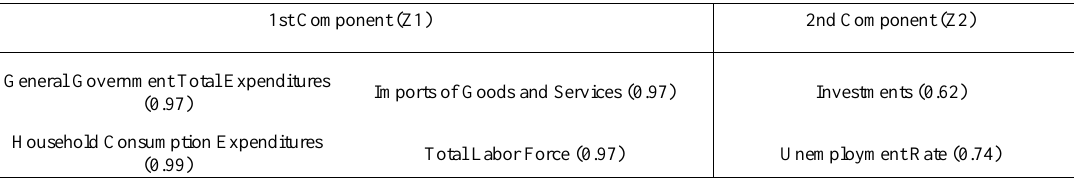
Table 2. The Two primary principal